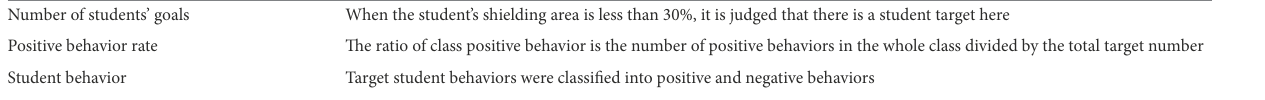
TABLE 7 The standards of the manual marking. Name (of a thing or organization) Criterion for judgment Number of students’ goals